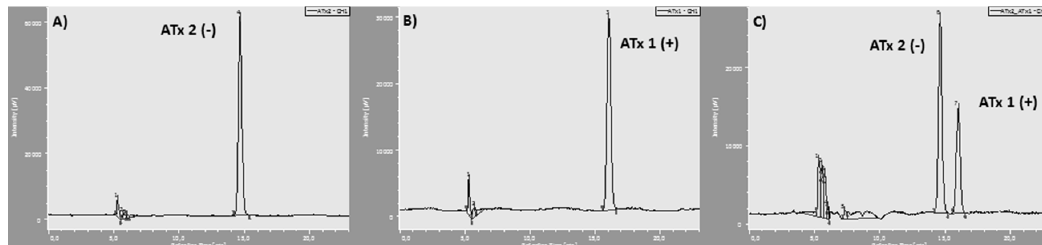
Figure 2. Chromatograms of the investigated compounds ( A ) ( R )-1-((1-hydroxypropan-2-yl)amino)-4-propoxy-9 H -thioxanthen-9-one (ATx 2 ( − )), ( B ) ( S )-1-((1-hydroxypropan-2-yl)amino)-4-propoxy-9 H -thioxanthen-9-one (ATx 1 (+)), ( C ) ( S , R )-1-((1-hydroxypropan-2-yl)amino)-4-propoxy-9 H -thioxanthen-9-one (mixture of ATx 1 (+) and ATx 2 ( − )) on Lux ® 5 μ m amylose-1 at 0.5 mL/min − 1 ; n -hexane:ethanol (70:30 v / v ), 0.5 mL/min, λ max 254 nm.